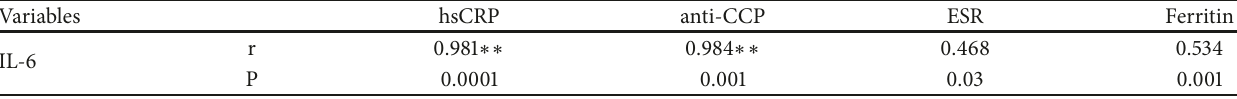
Table 3: Correlation between IL-6 and other inflammatory markers in RA patients.